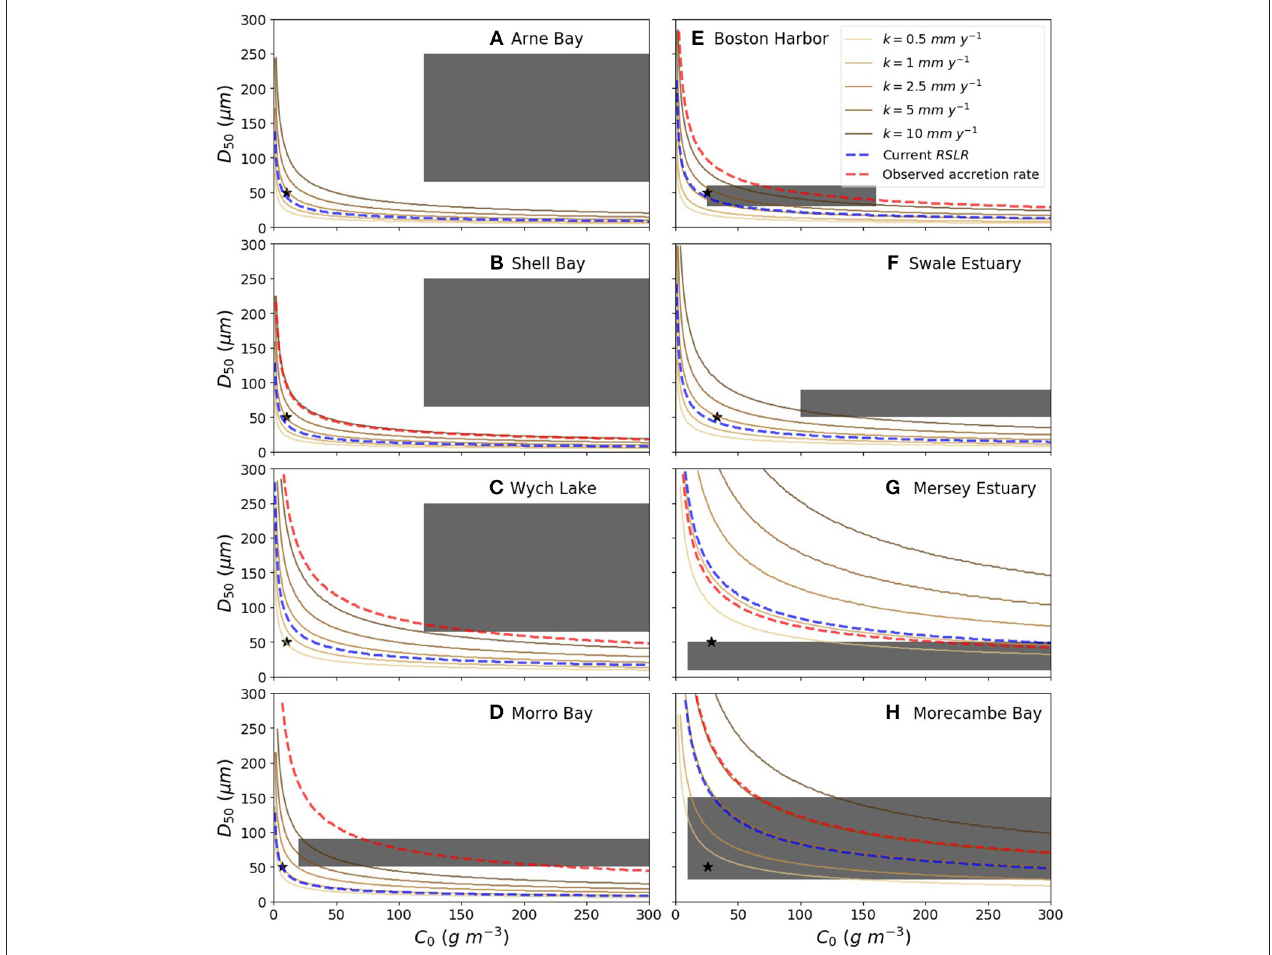
FIGURE 7 | Contour lines representing conditions on C 0 and D 50 for total accretion k = Q dep + Q org to reach the indicated values. Here, Q org = 0.06 · Q dep ; Gray boxes bound sediment supply conditions from low C 0 and D 50 to high C 0 and D 50 . Black stars represent C 0 conditions obtained from MERIS data, with D 50 = 50 µ m . Blue dashed lines represent the conditions required to match RSLR , and red dashed lines the conditions to match observed accretion rates. (A–H) Marsh sites examined, ordered by Mean Tidal